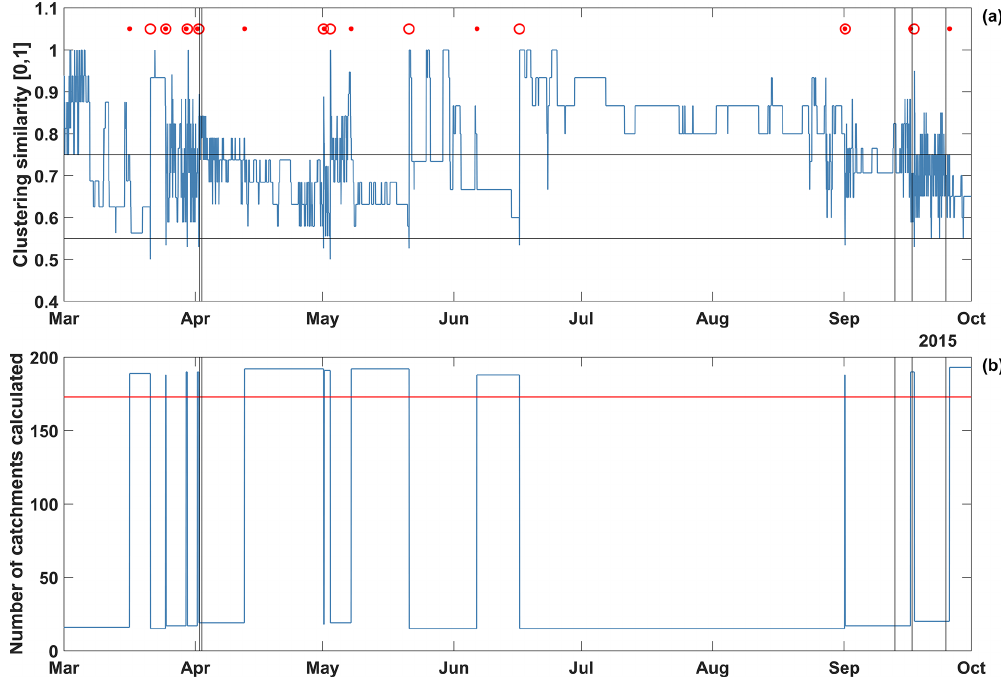
Figure 6. (a) Time series of agreement between inherited and current clusters, based on the adap-c optimal model run. Black vertical lines indicate times of special interest (see Figs. 3 and 4), black horizontal lines indicate the agreement thresholds given by parameters sim_crit and sim_uncrit (see Table 1). A red circle indicates when a jump back in time was triggered. The jump goes back to the next red dot to the left of each circle. (b) Number of subcatchments per time step for which hydrological processes were calculated. The red horizontal line indicates the total number of subcatchments (173) in the SHM Attert